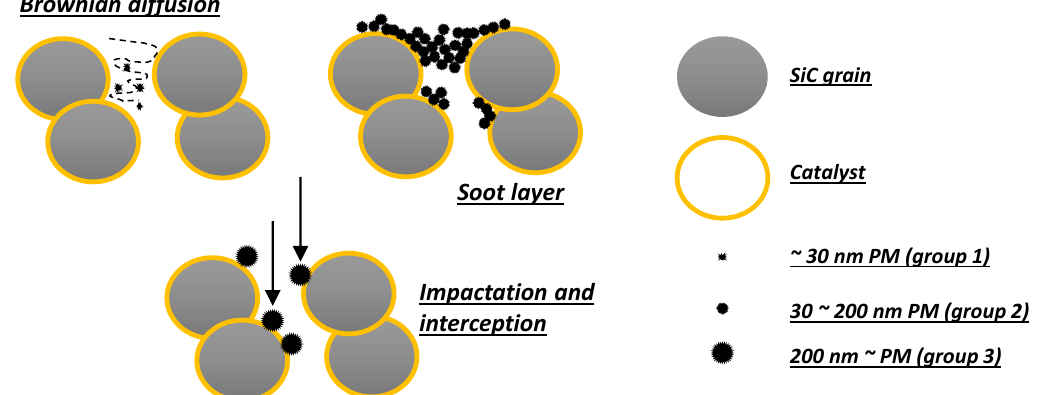
Figure 2. Classification of particle trap mechanisms by a catalyst-coated diesel particulate filter (DPF) on the basis of soot (PM) particle size. Adapted from [11].